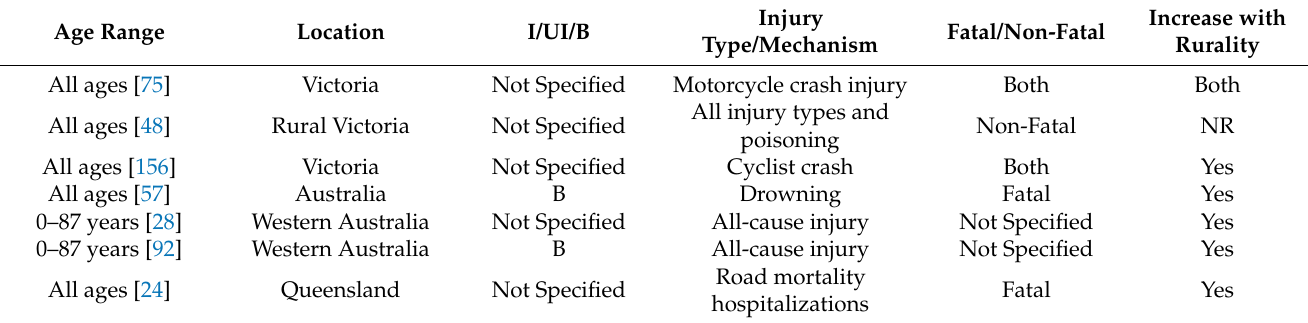
Table 4. All Age Rural Injury